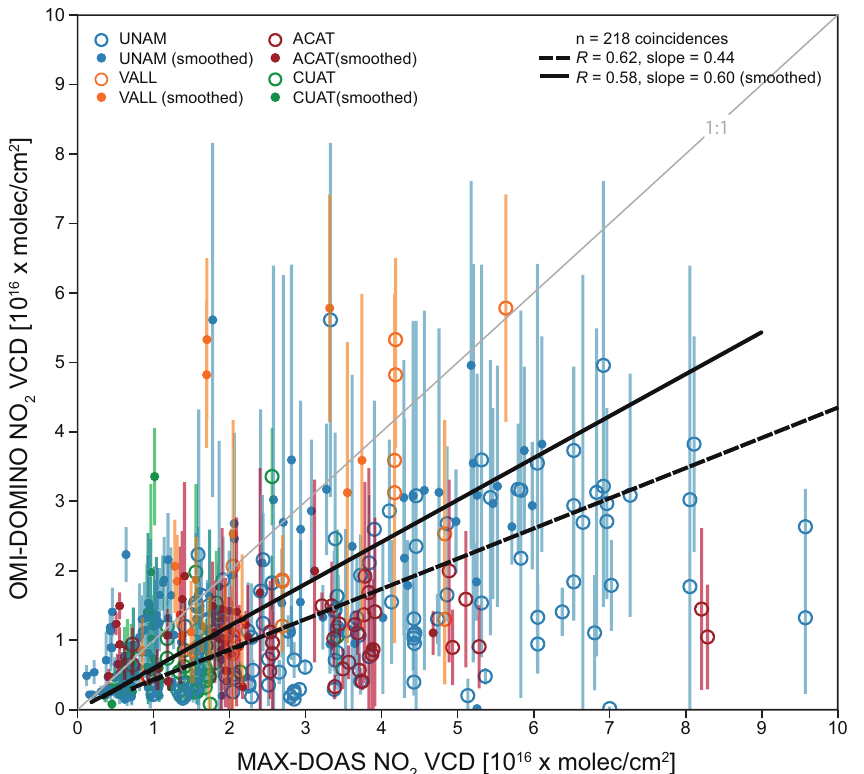
Figure 5. Correlation plots with coincident data pairs from OMI-DOMINO and all four MAX-DOAS instruments combined. Open circles correspond to the retrievals without any correction and the filled circles are smoothed with the satellite AK. Offsets forced to zero obtained with linear regressions of both data sets are shown with dashed and continuous lines, respectively.